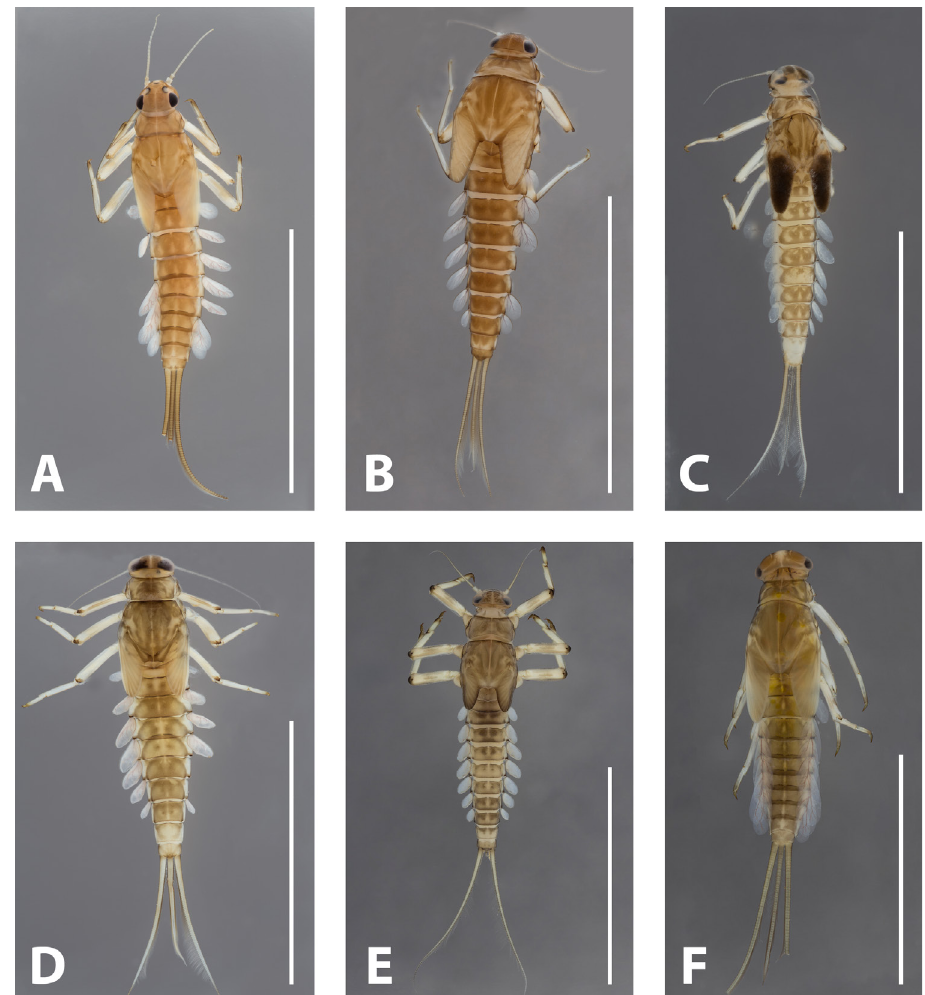
Figure 4. Nymphs of Israeli Baetis species, habitus. A Baetis aureus sp. n. B Baetis golanensis sp. n. C Baetis monnerati D Baetis noa sp. n. E Baetis pacis sp. n. F Baetis samochai . Scale bars: 5 mm. ute setae, both evenly distributed along margin; dorsoapical setal patch composed of 5–7 stout setae and 2–3 thin setae. Tibiae with dorsal and ventral rows of stout, point- ed setae; tibiopatellar suture present. Surface of trochanters, femora and tibiae with scattered feathered scales. Tarsi with 10–20 minute dorsal setae; 13–20 ventral pointed setae and submarginal row of shorter setae; one pointed seta, shorter than most ventral setae, at ventral tarsus-claw meeting point. Tarsal claws (Figure 6B) hooked, with row of 15–17 acute teeth. Mid- and hindlegs similar to forelegs. Abdomen. Terga shagreened with few thin setae, seta bases and very small scale bases (only slightly wider than seta bases); distal margin of all terga with row of trian- gular spines as broad as long (spines longer and more pointed on terga VII to IX),